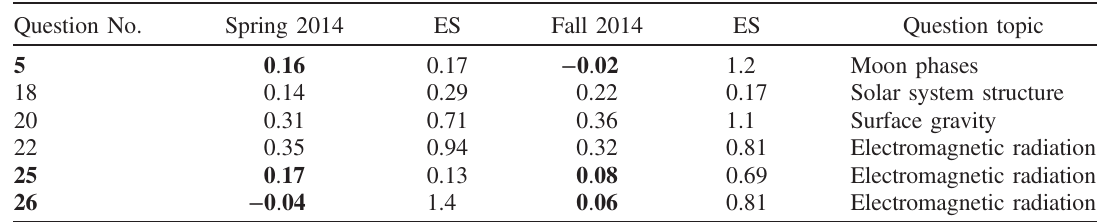
TABLE III. Learning gains and effect sizes for selected questions. Learning gains by class for TOAST questions deemed to be closely tied to material covered in ASTRO 001V minigames. Questions selected for further analysis indicated in boldface. Effect sizes (ES) come from comparison to average gain score of 0.19, discussed above. Question